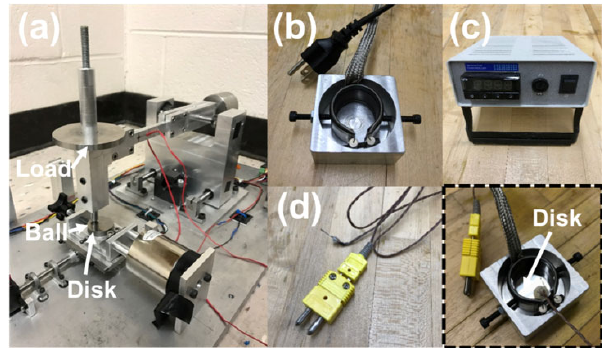
Fig. 1 Images of (a) reciprocating ball-on-flat tribometer and (b–d) experimental kit used for tribotests in high temperature: (b) sample holder, (c) temperature controller, and (d) thermal couple. Fig. 2 NMR spectrum of